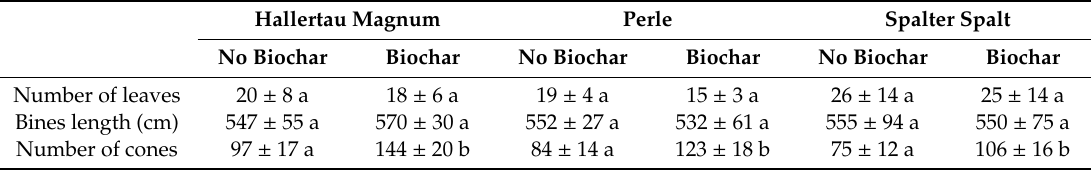
Table 2. Measurements of number of leaves (mean ± standard deviation) at the beginning of May, and climbing bines length and number of cones at maturity. Statistical di ff erences between treatments (with biochar or without biochar) for each cultivar and parameter are displayed with di ff erent letters (a or b). Hallertau Magnum Perle Spalter Spalt No Biochar Biochar No Biochar Biochar No Biochar